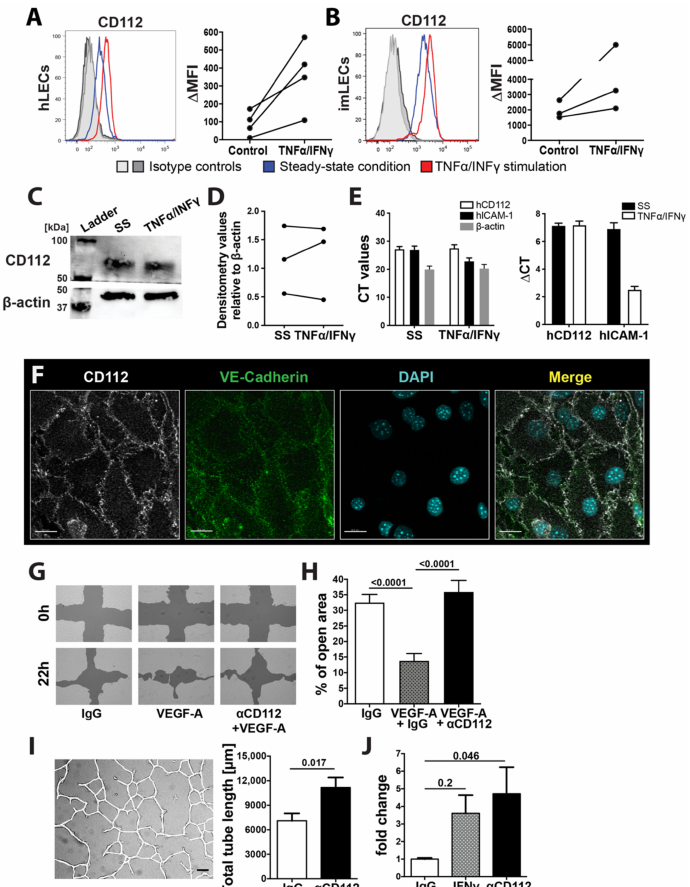
Figure 2. CD112 regulates endothelial cell function in vitro. ( A , B ) Flow cytometry analysis showing CD112 expression by human ( A ) and conditionally immortalized murine LECs (imLECs) ( B ). Representative flow cytometry plots of CD112 expression comparing steady-state (blue line) and inflamed conditions (red line: TNF α /IFN γ treated; grey lines: isotype controls) are shown on the left. Summary of MFI values of CD112 expression of three to four experiments are shown on the right. Data points of the same experiment are connected by a line. ( C ) Western blot analysis configure 112. protein (~65 kDa) expression in in vitro cultured human LECs in steady-state (SS) and upon TNF α /IFN γ -mediated inflammation. β -actin was used as an internal control. Blots were cut at the 50 kDa ladder mark. Representative data from one out of three experiments are shown. ( D ) Summary of densitometry signal intensities of CD112 protein in steady state (SS) and upon TNF α /IFN γ -mediated inflammation normalized to β -actin signal of three Western blot experiments. Data points from the same experiment are connected by a line. ( E ) Quantitative real-time PCR analysis of CD112 mRNA levels in in vitro cultured human LECs in steady-state (SS) and upon TNF α /IFN γ -mediated inflammation. Induction of ICAM-1 mRNA levels by TNF α /IFN γ was analysed as a positive control. Delta cycle threshold (CT)values: Difference between the CT values measured for CD112 and for the housekeeping gene RPLP0. Pooled data (experimental means) from three independent experiments (biological replicates) are shown. Each experiment was performed in triplicate (technical replicates). ( F ) Representative immunofluorescence images of CD112 expression (white) on in vitro cultured imLEC monolayers colocalizing with the junctional molecule VE-cadherin (green) at the intercellular junctions. Scale bar: 20 µ m. ( G , H ) Human LEC migration upon CD112 blockade was investigated in an in vitro scratch assay. ( G ) Representative images of an LEC scratch assay in VEGF-A-induced wound closure. Scale bars: 200 µ m. ( H ) Pooled quantitative analysis from three independent experiments are shown. ( I ) Representative image (left) of an in vitro tube formation assay. Confluent human LEC monolayers were incubated overnight in collagen gel solution supplemented with blocking antibody for CD112 or isotype control. Total tube length was manually analysed using a self-made macro in FIJI (ImageJ). Quantitative analysis (right) of total tube length upon CD112 blockade. One out of three similar independent experiment is shown. ( J ) In vitro permeability assay, in which 70 kDa FITC dextran was applied onto confluent pretreated LEC monolayers grown on a Boyden transwell membrane. After 30 min, diffused FITC dextran was quantified in the lower chamber. Pooled data from three similar and independent experiments are